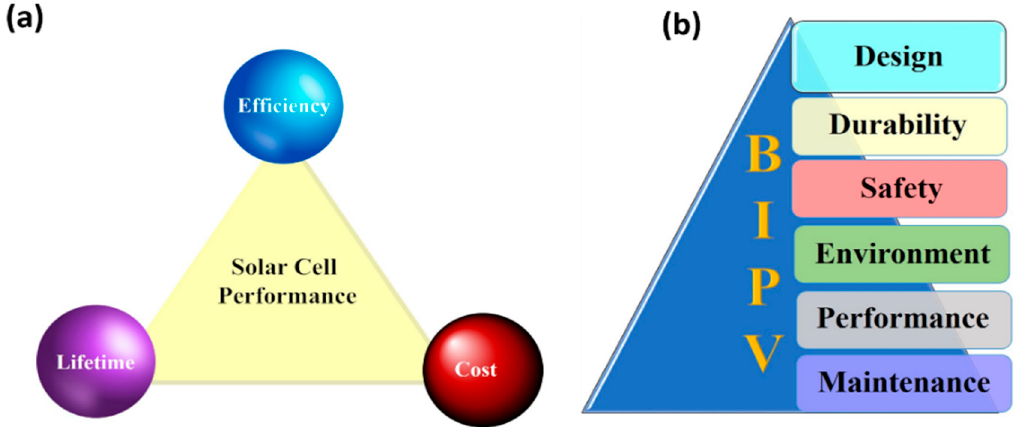
Figure 11. ( a ) Golden triangle of solar cells bonded with the cost, efficiency and lifetime parameters and ( b ) parameters for PV building integration.